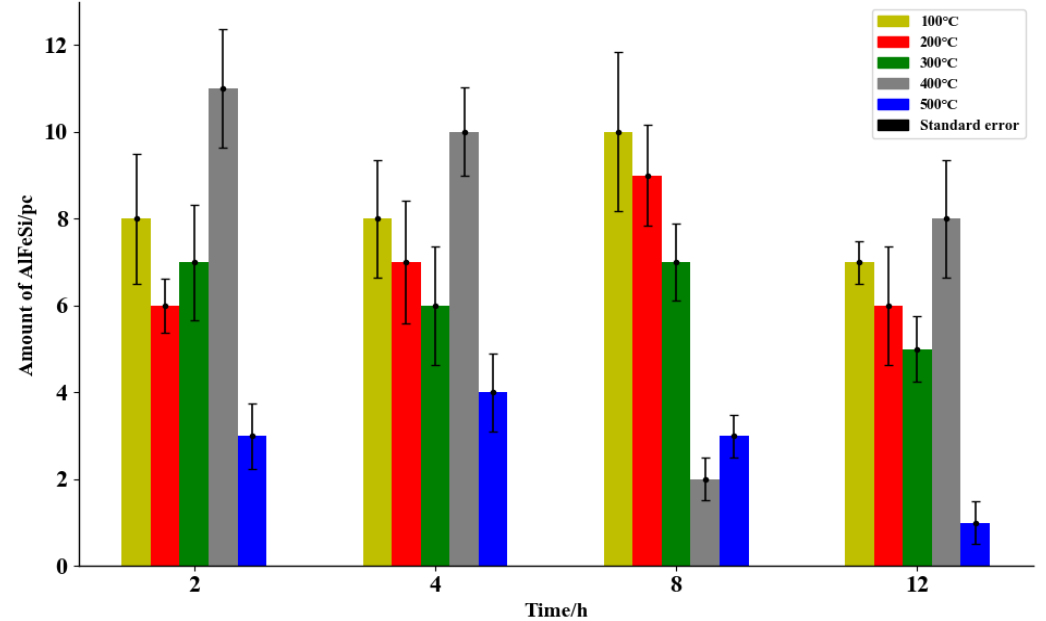
Figure 8. E ff ects of heating time and heating temperature on the amount of Figure 8. Effects of heating time and heating temperature on the amount of AlFeSi.